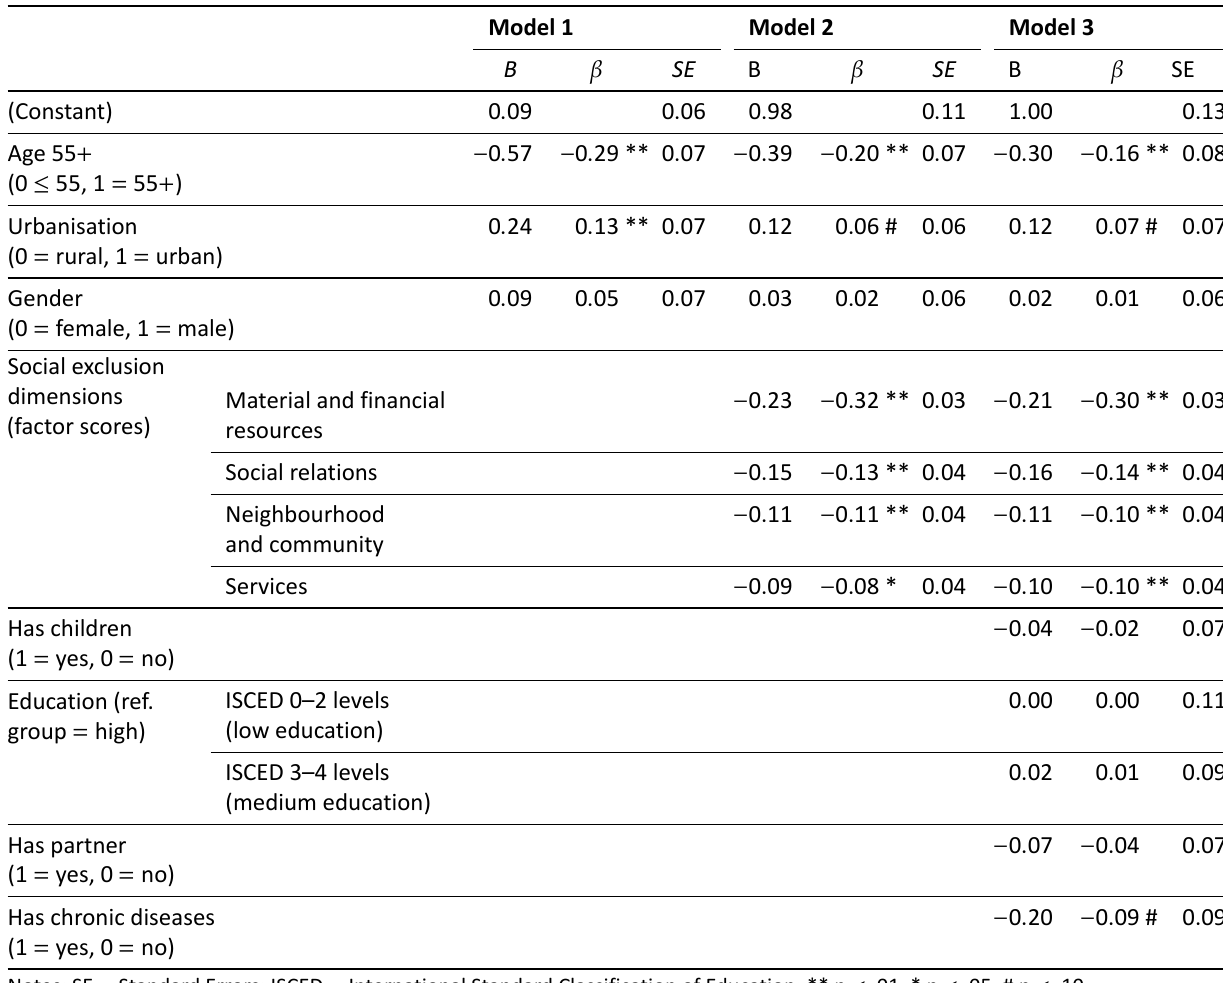
Table 2. Summary of the hierarchical regression analysis for variables predicting mental wellbeing (N =